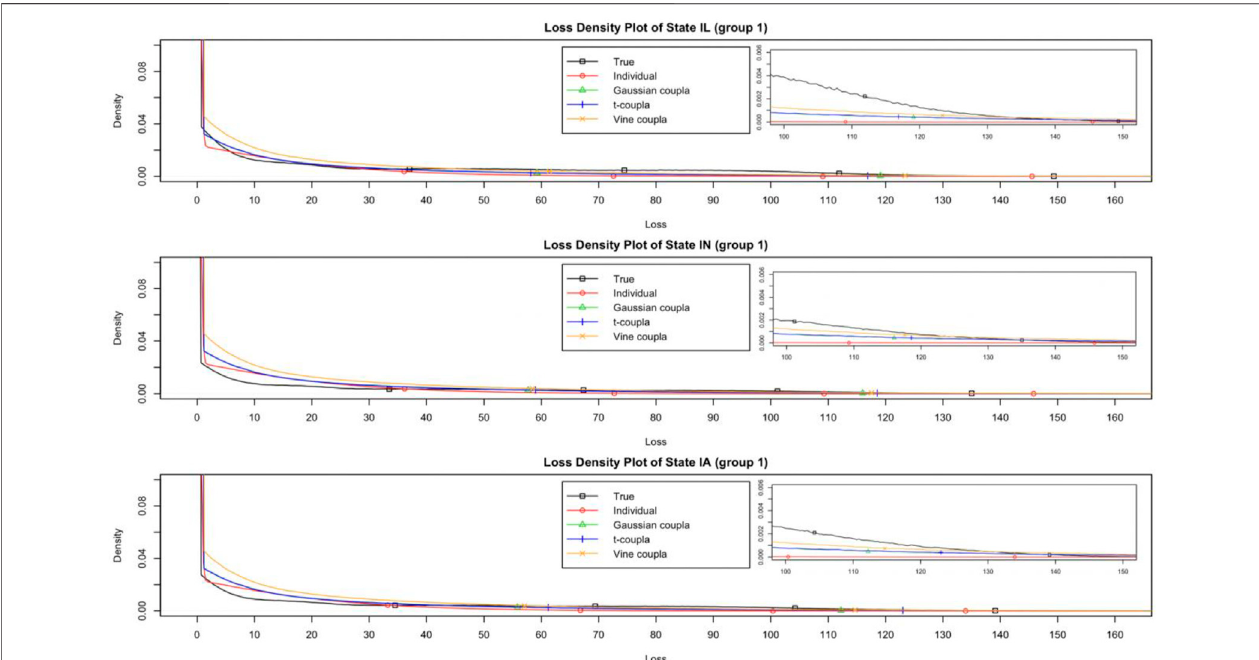
FIGURE 2 | The losses density plot for states in Group 1 (Weibull distribution with a duration of 30 years).